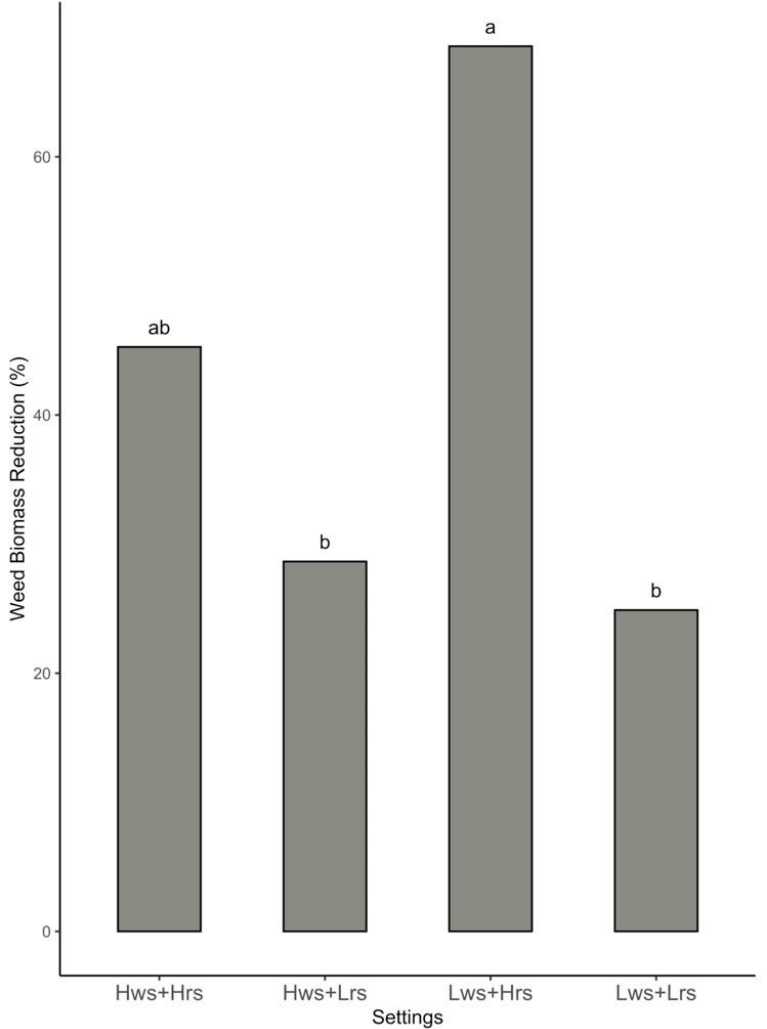
Figure 6. Effect of setting configurations on weed biomass reduction. Means denoted by different letters are significantly different at p < 0.05 (LSD test). Hws—High working speed; Lws—low working speed; Hrs—high rotation speed; Lrs—low rotation speed. Mowers with the Lws + Hrs setting also produced smaller clippings (back-transformed mean value of 6.77 cm) compared to the other setting configurations (back-transformed mean values ranging from 7.93 to 8.31 cm) ( p < 0.05). Results achieved with the other setting configurations were similar (Figure